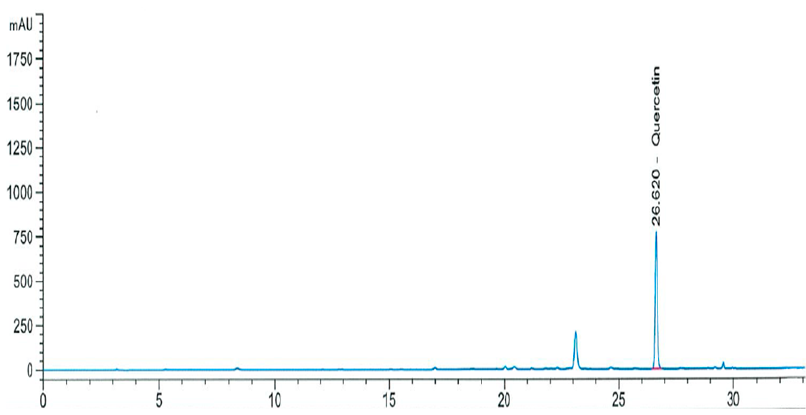
Figure 2. Chromatogram of quercetin in OS extract analyzed by LC. Table 2. Quercetin concentration and total phenolic content of A. cepa skin (OS) extracts.